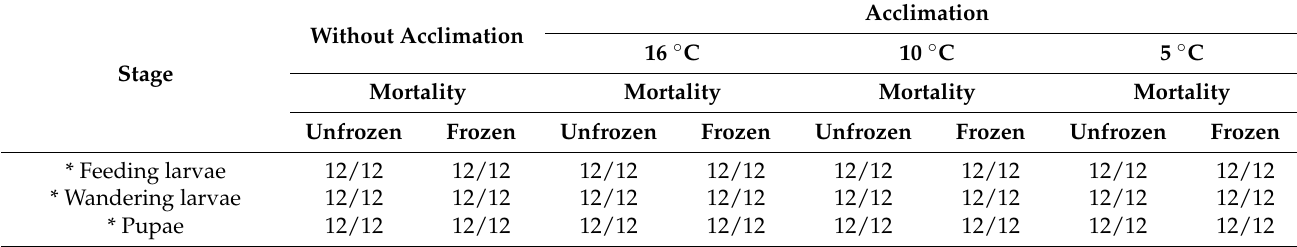
Table 2. Mortality of immature stages of SHB with acclimation and without acclimation to determine cold tolerance strategy.